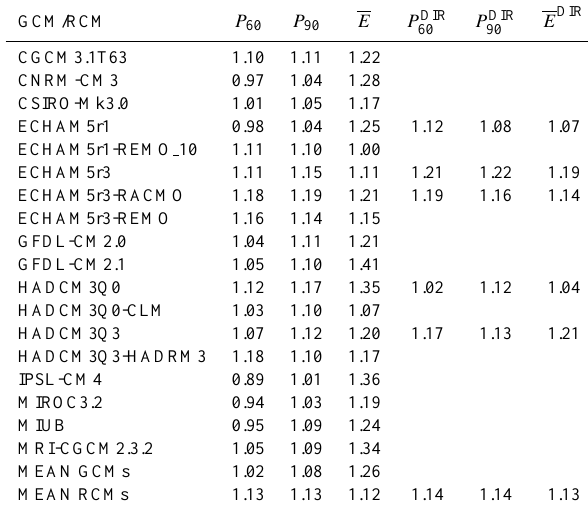
Table 2. Relative changes in the 60% quantile ( P 60 ), the 90% quantile ( P 90 ) and mean excess ( E ) after a transformation of the 5-day precipitation sums of the observed precipitation based on the simulated changes between 1961–1995 and 2081–2100 of a GCM or RCM. The changes are basin-average relative changes for the winter half-year (October–March). The changes between the ob- served and transformed data were obtained by taking the median of the relative changes of the temporally smoothed estimates for each calendar month over the eight grid cells at the common GCM resolution and averaging these medians for the winter half-year. For the RCMs, the transformation was applied after the RCM out- put was aggregated to the GCM grid resolution. The results in the columns headed P DIR , P DIR 60 90 bias-corrected RCM output from the RheinBlick2050 project. For tween the RCM control and RCM future period.